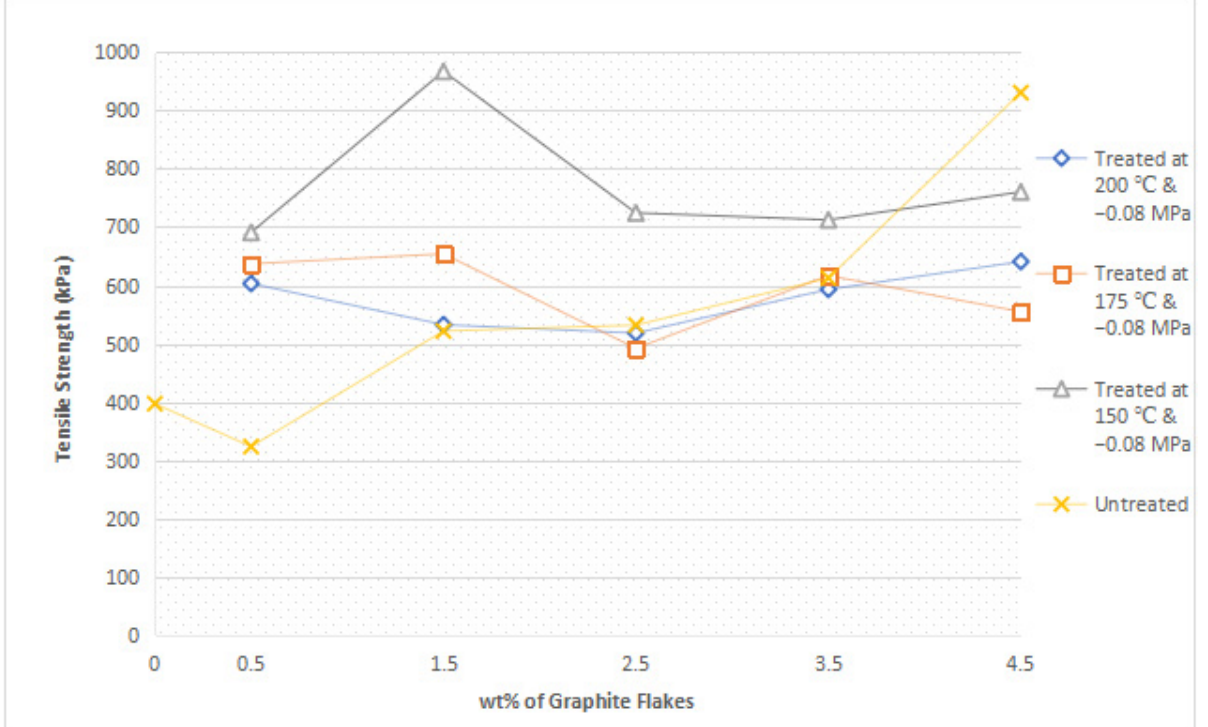
Figure 2 . Average Tensile Strength of All the Nylon 610/Graphite Flake Nanocomposites . Figure 2. Average Tensile Strength of All the Nylon 610/Graphite Flake Nanocomposites. The decrease in tensile strength for nanocomposites with graphite flakes treated at 175 ◦ C and 150 ◦ C from 1.5 wt% onwards is due to the increasing amounts of flakes within the nylon 610 matrix, which gives rise to agglomerates of the nanofiller particles. The formation of aggregates at higher wt% can be seen in Section 3.4. This is seen when it was the nanocomposite incorporated with 1.5 wt% flakes (a low loading level) treated at 150 ◦ C that possessed the highest tensile strength (967.02 kPa) out of all the composites. These agglomerates would then result in a weaker interfacial interaction between them and the polymer matrix due to having a lower surface area. Additionally, the irregular shape and size of the graphite flake agglomeration would decrease the efficiency of stress transfer from the matrix to the nanofillers. The random positions of the agglomerates could also act as points of defect within the matrix, further weakening the overall mechanical performance of the